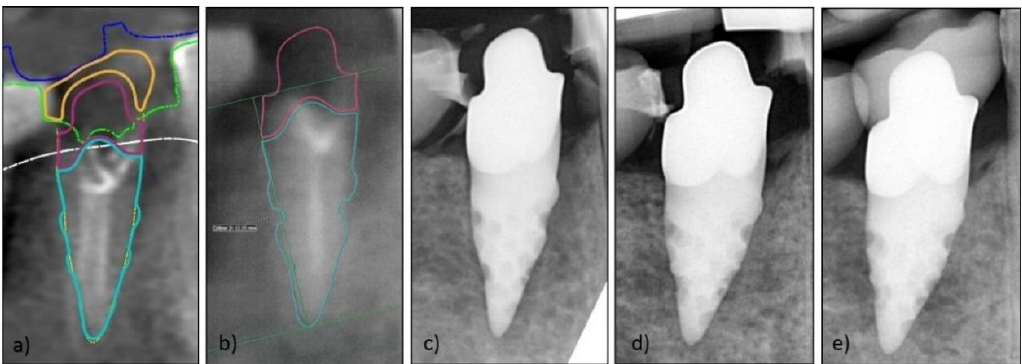
Figure 3. Exemplary series of X-rays for marginal bone loss (MBL) measurement: ( a ) visualized RAI construction by Natural Dental Implants (NDI); ( b ) initial image for measurement of bone loss; ( c ) X- ray post-implantation; ( d ) X-ray after healing time (before impression for loading); ( e ) X-ray after loading.